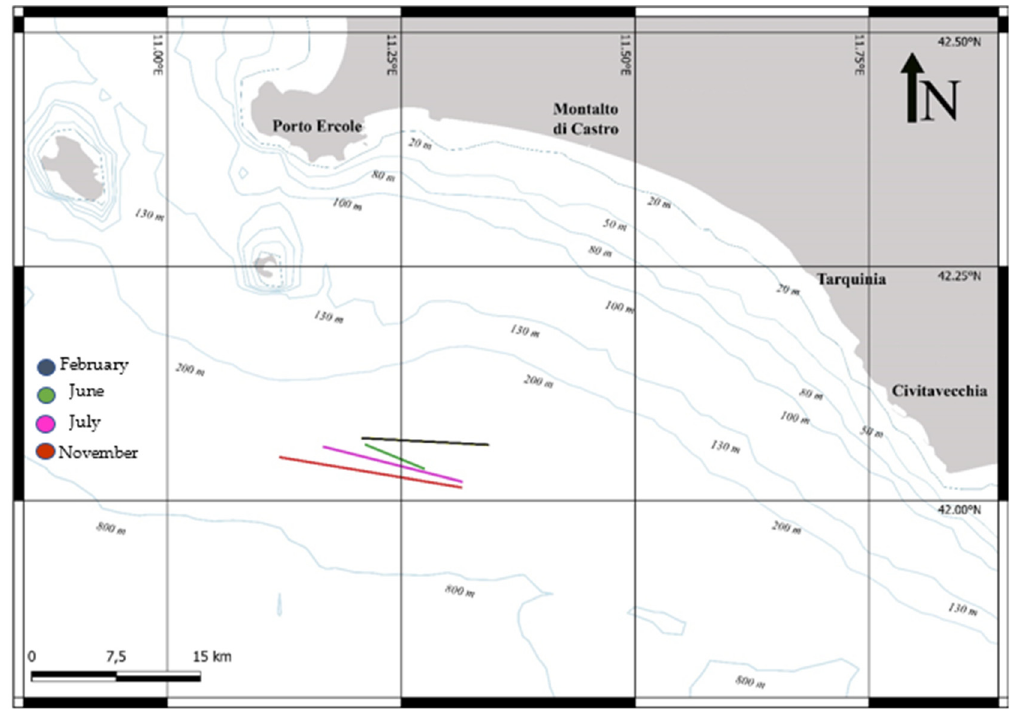
Figure 1. Study area with indications of haul routes carried out during 2017, bathymetry and main fishing harbours in the eastern central Tyrrhenian Sea